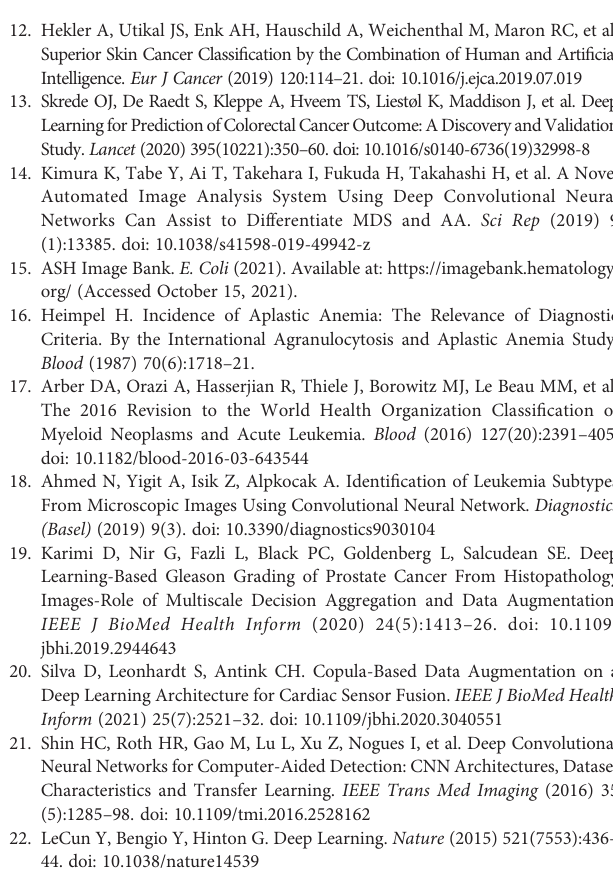
Supplementary Figure 1 | ROC curves of the two-classi fi cation model with different outcome weights. (A) ROC curves of 5:5 outcome weight; (B) ROC curves of 2:8 outcome weight; (C) ROC curves of 1:9 outcome weight. Supplementary Figure 2 | ROC curves of the two-classi fi cation model with different epochs. (A) ROC curves of 30 epochs; (B) ROC curves of 50 epochs; (C) ROC curves of 200 epochs. Supplementary Figure 3 | ROC curves of the three-classi fi cation model with different outcome weights. (A) ROC curves of 5:5 outcome weight; (B) ROC curves of 2:8 outcome weight; (C) ROC curves of 1:9 outcome weight. Supplementary Figure 4 | ROC curves of the three-classi fi cation model with different epochs. (A) ROC curves of 30 epochs; (B) ROC curves of 50 epochs; (C) ROC curves of 200